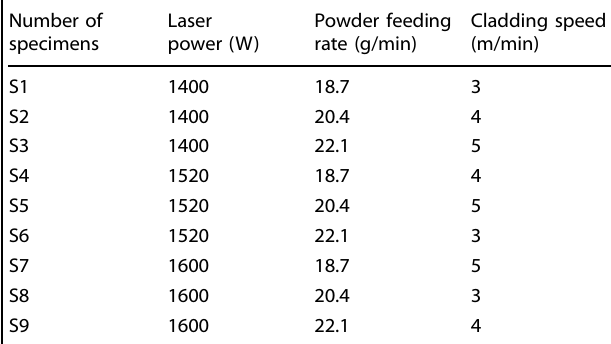
Table 9. Multiple variations in processing parameters of Inconel 625